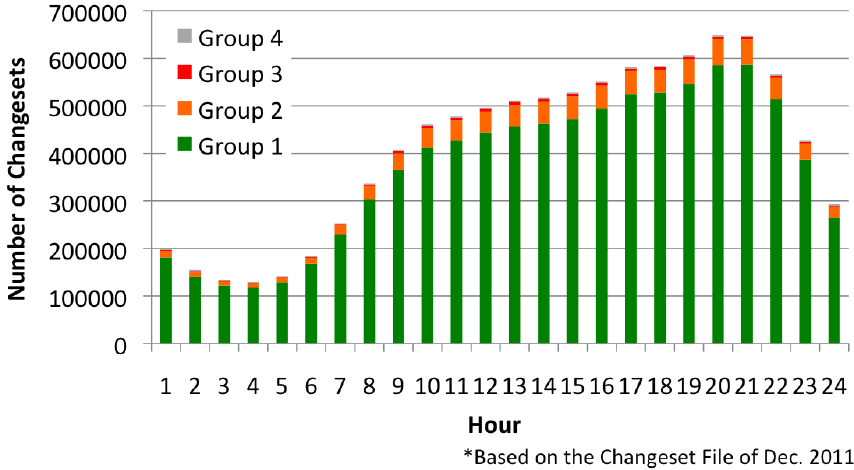
Figure 6. Changesets per